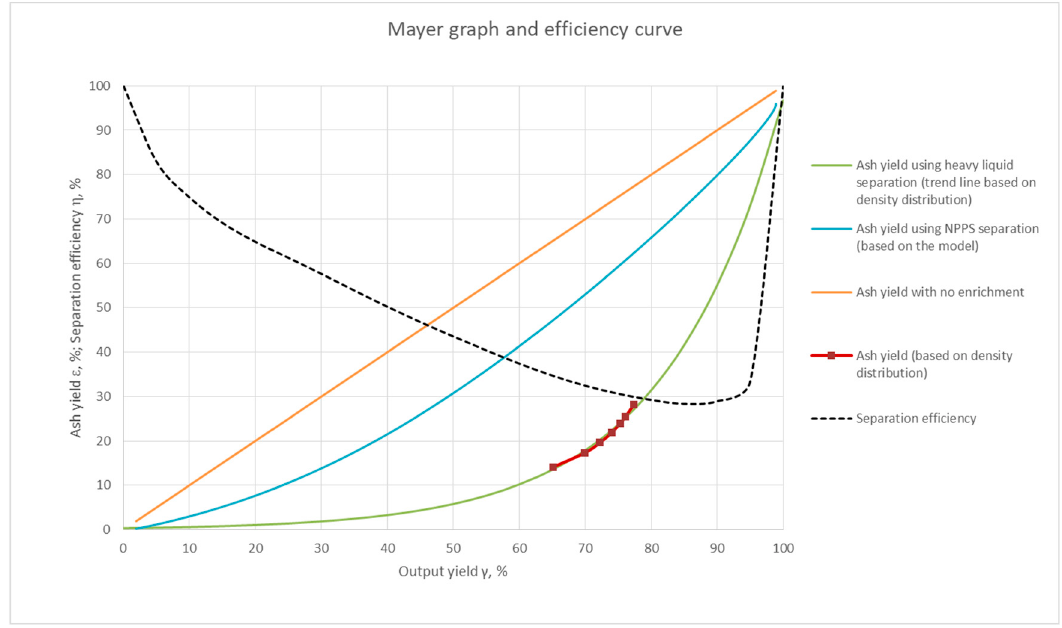
Figure A3. Assessment of the efficiency of coal separation with the use of the NPPS in comparison to wet methods—feed material no. 2 in grain size class 0–20 mm.